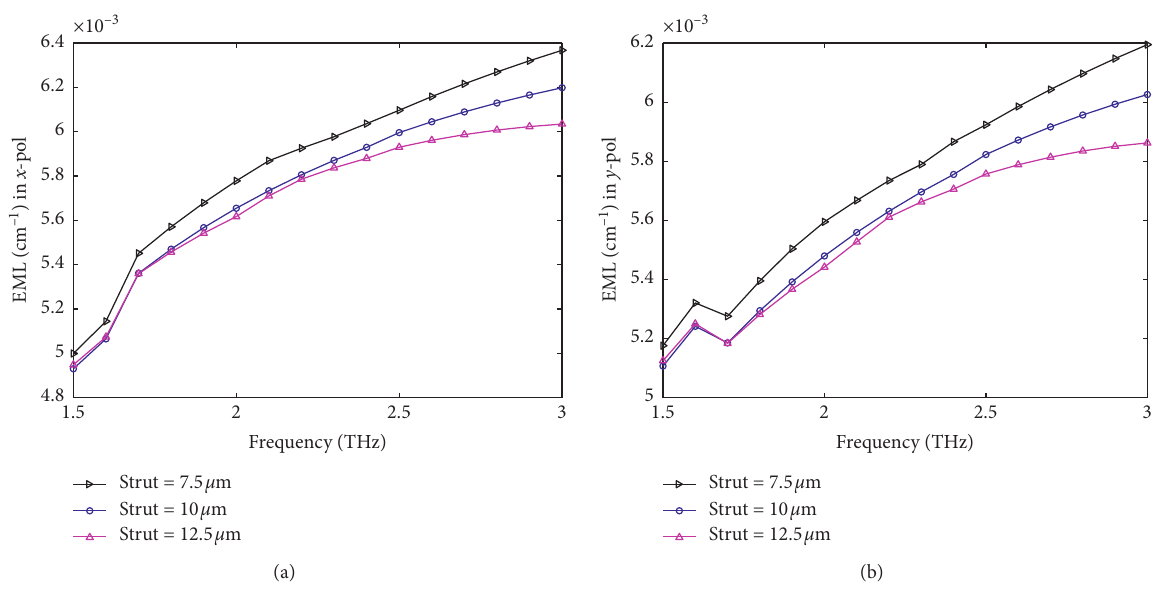
Figure 11: Representation of the EML in the THz band for the three different strut values. (a) x -PoM and (b) y -PoM.